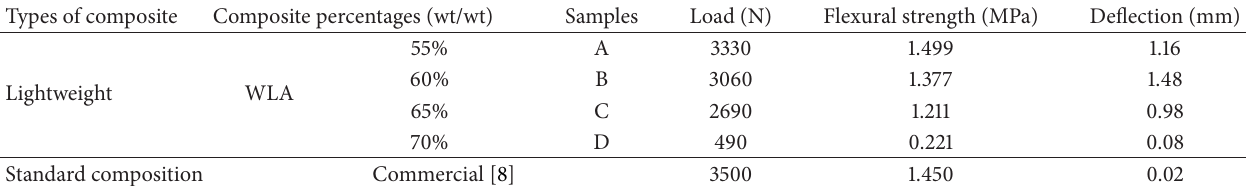
Table 4: Flexural strength and density of standard and lightweight cube concrete with different ratio of WLA to cement (wt/wt). Types of composite